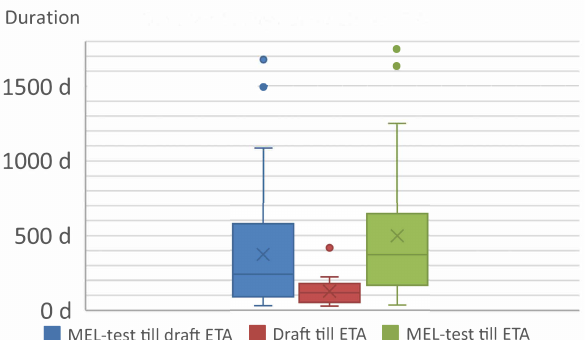
Figure 3. Time needed for a manufacturer to obtain an ETA. MEL, Maximum Energy